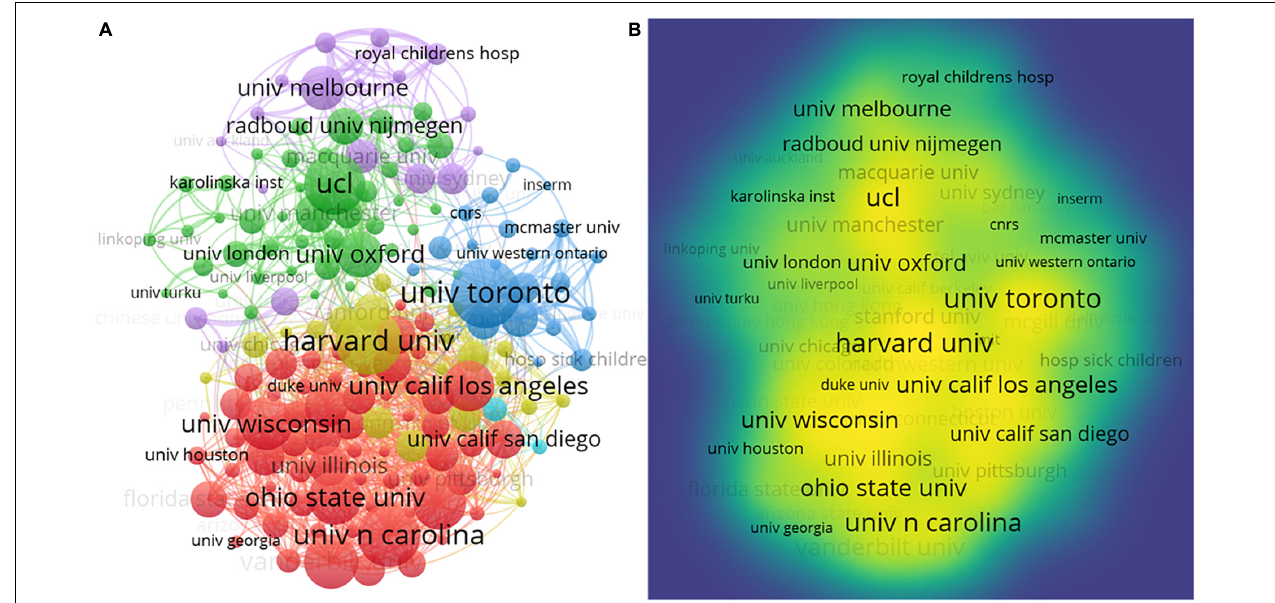
FIGURE 6 | The visualization map of research organizations. (A) An organizational network visualization map; (B) a density visualization map.